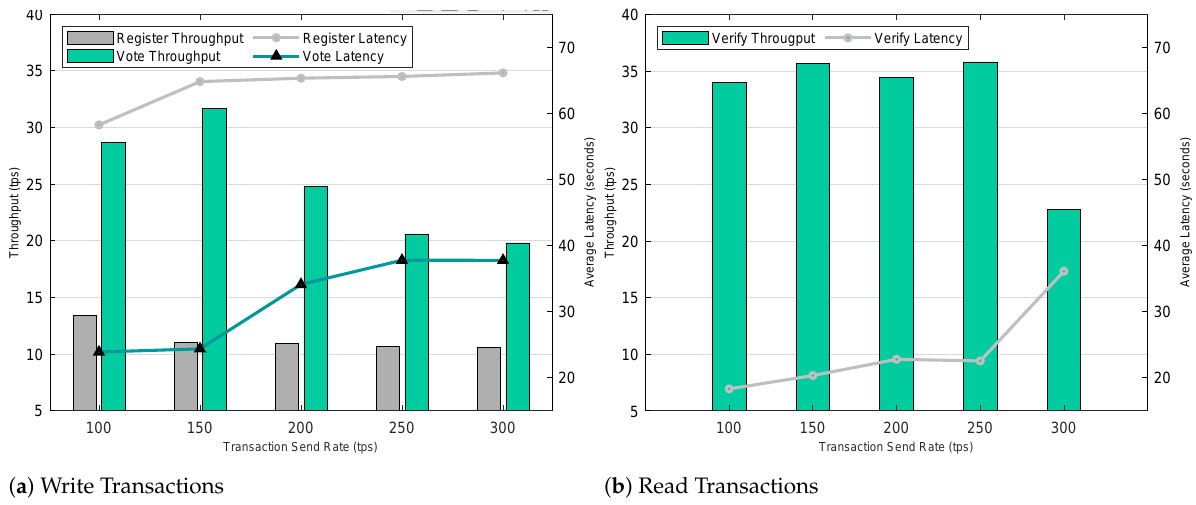
Figure 3. Impact of increasing transaction rates on latency and